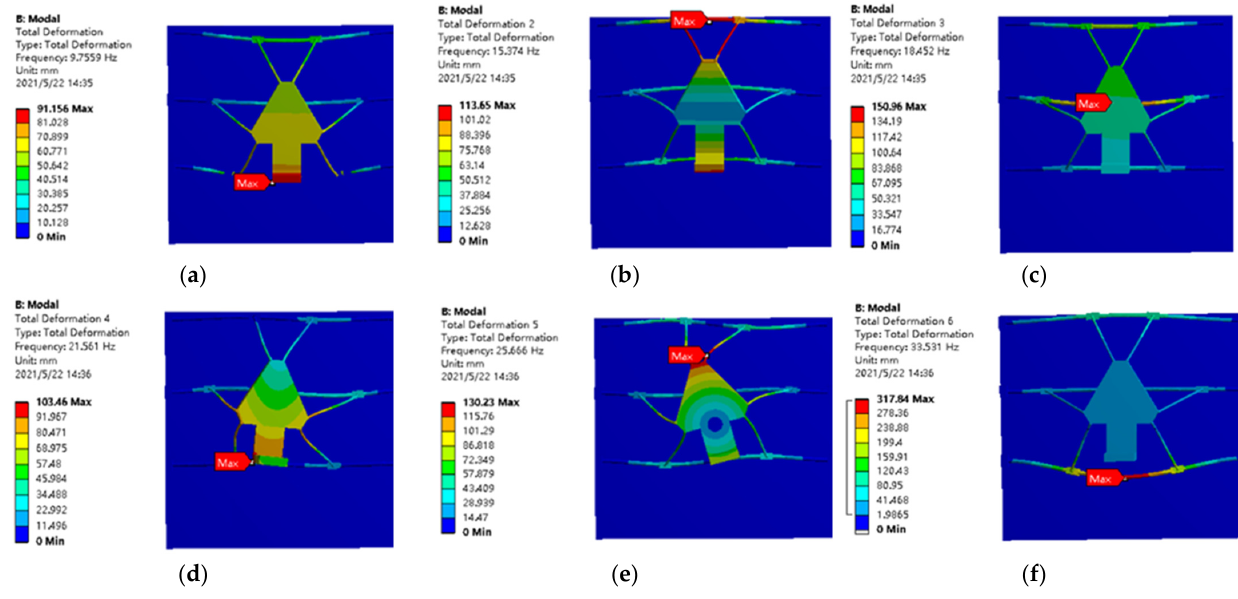
Figure 13. Modal simulation results: ( a ) first-order mode; ( b ) second-order mode; ( c ) third-order mode; ( d ) fourth-order mode; ( e ) fifth-order mode; ( f ) sixth-order mode.